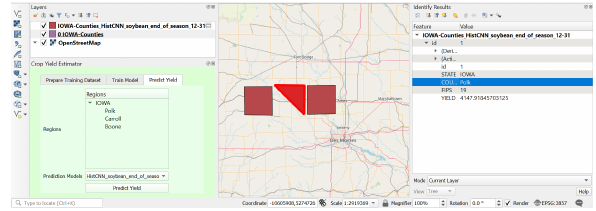
Figure 6. Preparing training dataset is completed